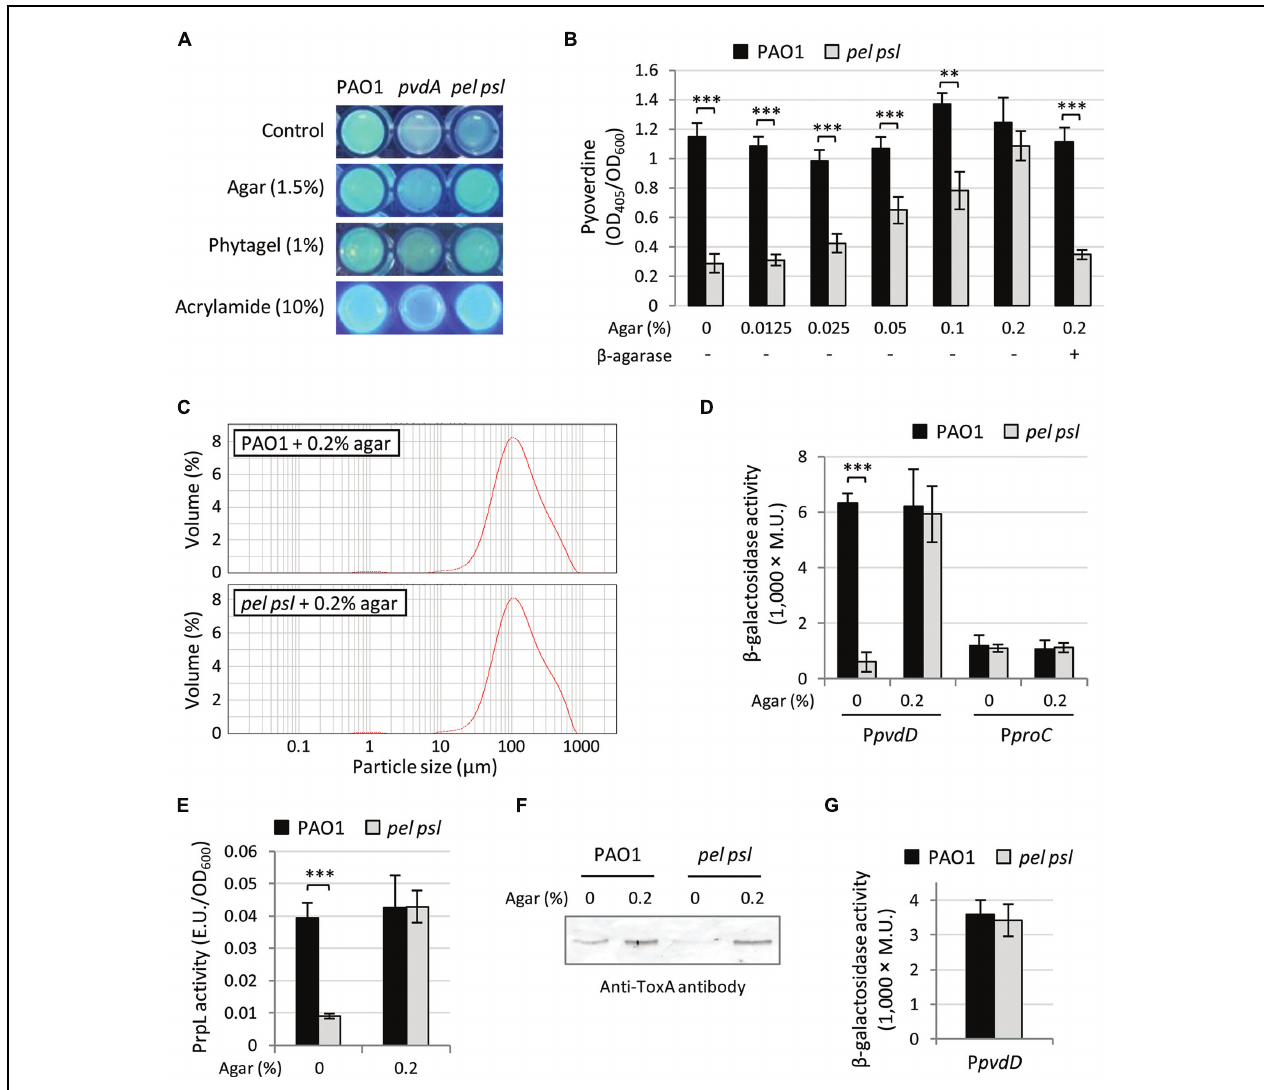
FIGURE 4 | Cell aggregation is involved in Pel and Psl-mediated control of pyoverdine-dependent virulence factors. (A) Fluorescent phenotype upon UV light exposure of P. aeruginosa PAO1, the pel psl mutant and the pvdA mutant (used as pyoverdine-deficient negative control) grown in liquid TSBD medium (Control) or on TSBD solidified with 1.5% agar, 1% phytagel, or 10% polyacrylamide. (B) Pyoverdine production by P. aeruginosa PAO1 and the pel psl mutant grown in TSBD supplemented with increasing concentrations of agar (0–0.2%) and/or β -agarase I (3.3 units/ml). (C) Representative LDA particle-size scans of P. aeruginosa PAO1 and pel psl cultures in TSBD supplemented with 0.2% agar after 14 h of growth at 37 ◦ C. (D) Activity of the P pvdD::lacZ and